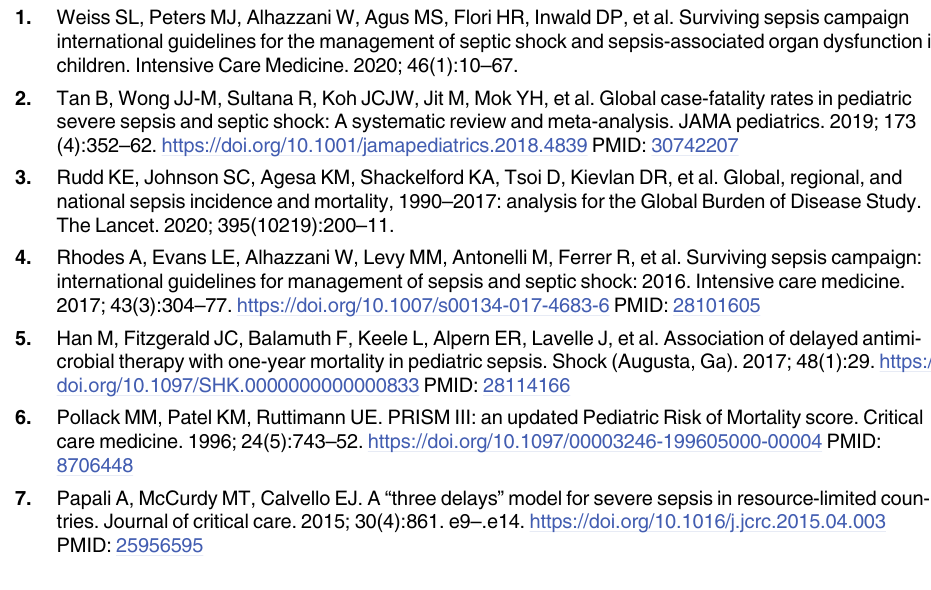
S1 Table. Key assumptions of the decision analytic